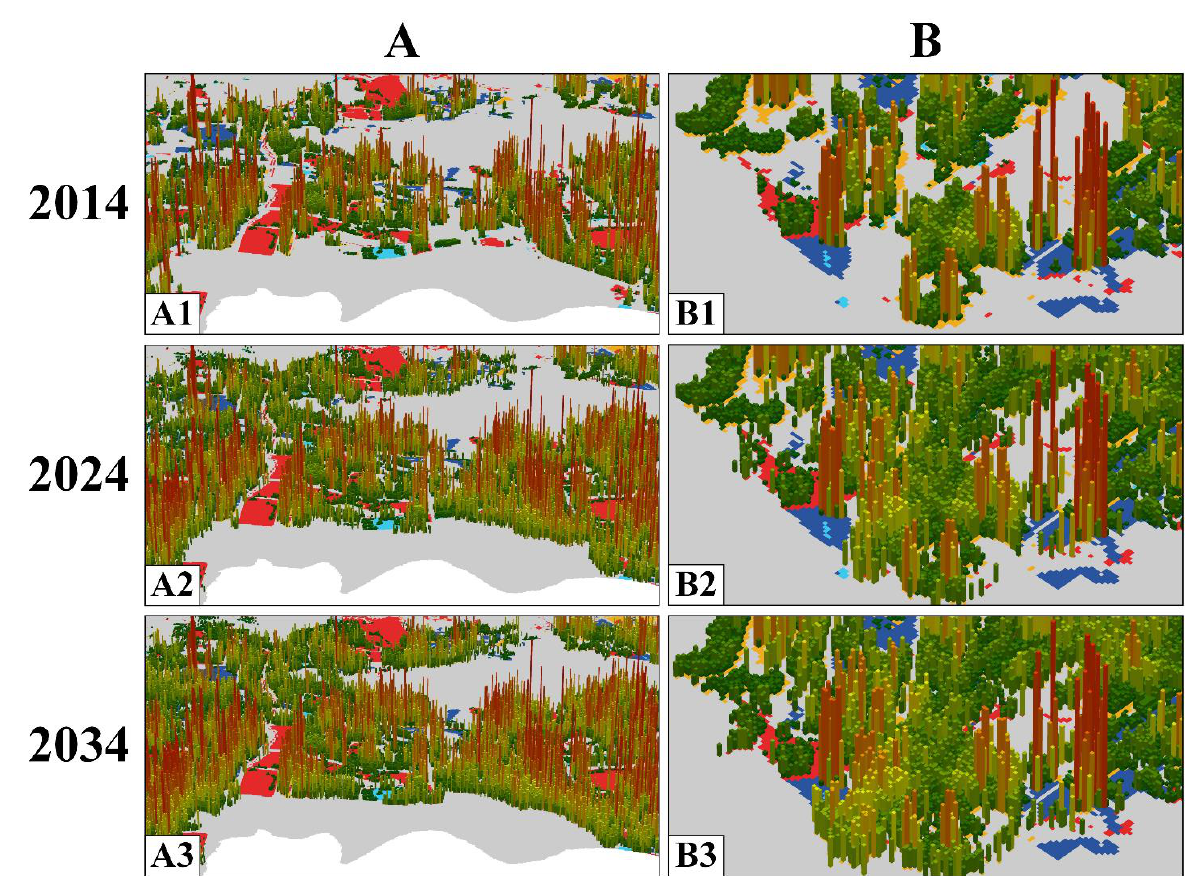
Figure 12. Predicted results of building height growth of Shenzhen in the vertical direction, 2014 – 2034. (A) The region near Shenzhen Bay; (B) The region near the Shenzhen North Railway Station in the south of Longhua District; A1, A2 and A3 represent the predicted results of building height growth of region A in 2014, 2024 and 2034; B1, B2 and B3 represent the predicted results of building height growth of region B in 2014, 2024 and 2034.